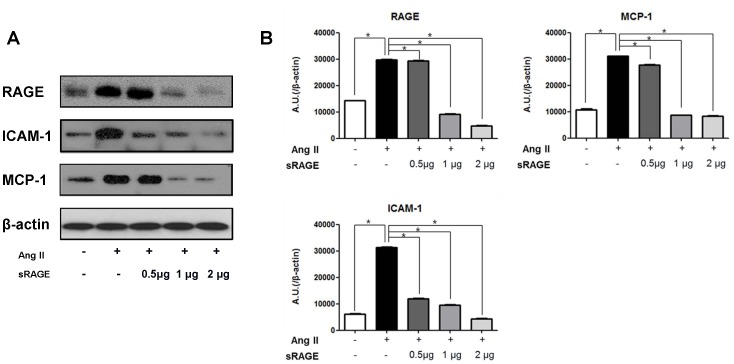
Effect of sRAGE in Apo E KO mice on Expression of Cytokines and Adhesion Molecules.A-B. Apo E KO mice infused with AngII were treated with various concentrations of sRAGE. Expressions of RAGE, ICAM-1 and MCP-1 were detected by western blot. The optical density is expressed in arbitrary units normalized against β-actin control. Data in histograms represent mean ± SD from individual 3 experiments. Lane 1, saline injection; lane 2, infusion of AngII; lane 3, infusion of AngII with 0.5 µg/day of sRAGE; lane 4, infusion of AngII with 1 µg/day of sRAGE; lane 5, infusion of AngII with 2 µg/day of sRAGE, *p<0.01.